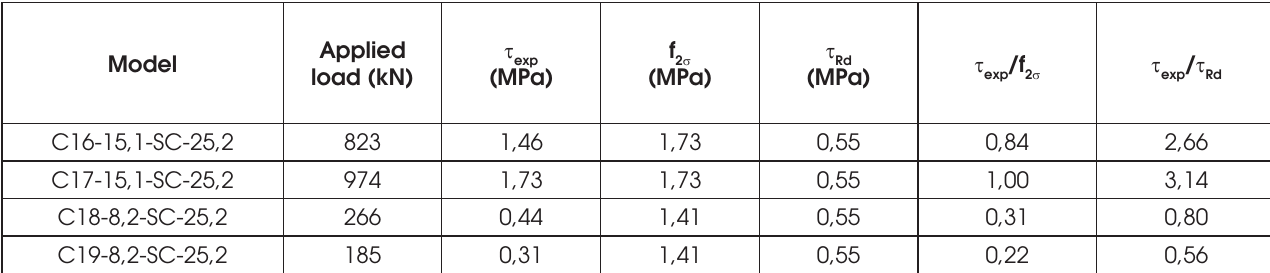
Experimental bond stress